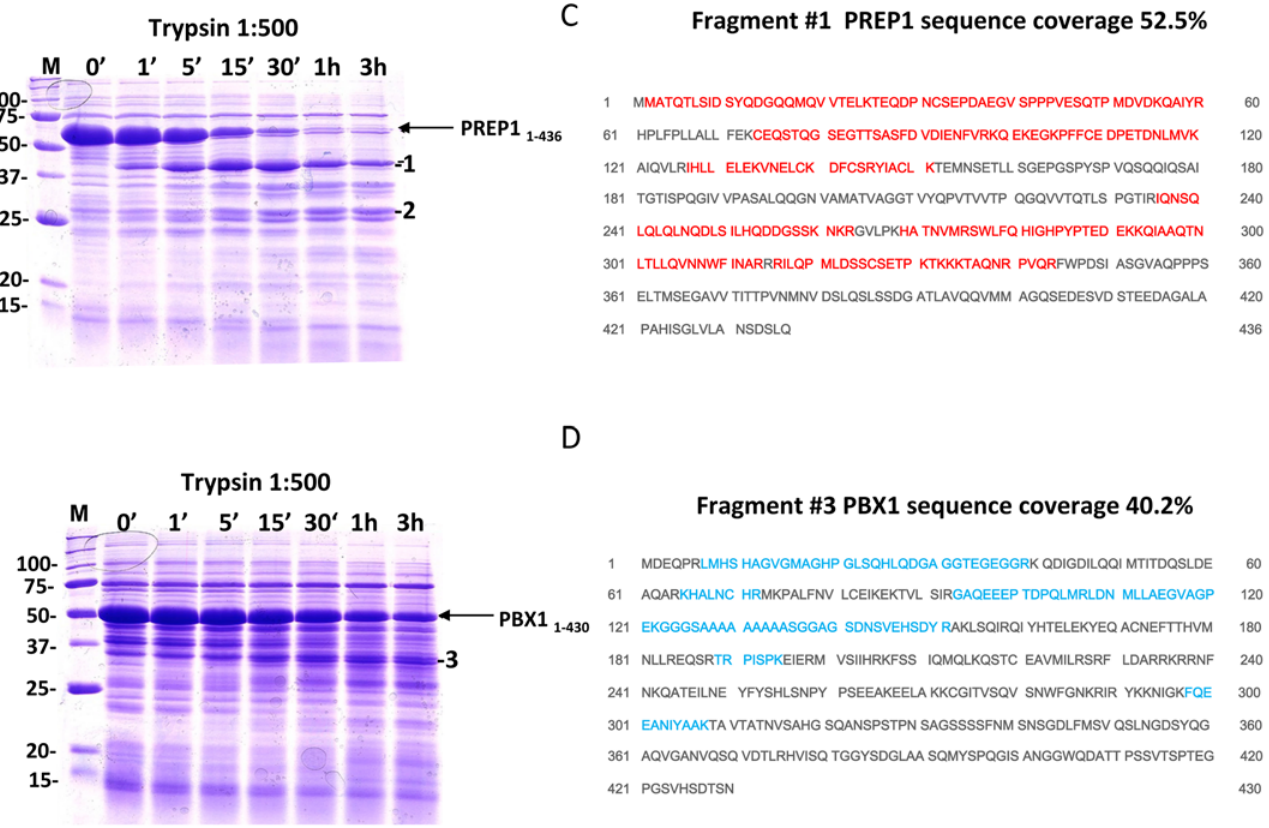
Fig 1. Limited proteolysis analysis of recombinant PREP1 and PBX1. Full length PREP1 and PBX1 were subjected to limited proteolysis with trypsin. The reactions (total volume 100 μ l) were performed at room temperature, 10 μ l volumes were taken out at the indicated time points, supplemented with sample buffer and boiled prior to loading onto SDS PAGE. The gels were Coomassie stained. A. Limited proteolysis of PREP1. Lane M, Bio-Rad size standard; two bands of ~40 kDa (1) and ~28 kDa (2) were chosen for subsequent N-terminal sequencing. B. Limited proteolysis of PBX1 with trypsin. Lane M, Bio-Rad size standard; band 3 is the proteolysis fragment chosen for mass spectrometry analysis. C and D. Identification of PREP1 and PBX1 fragments by MALDI-TOF mass spectrometry analysis. Peptides of PREP1 and PBX1 were identified by MALDI-TOF analysis after digestion of fragments 1 – 3 with trypsin. Fragment 1 contained PREP1 and the matching peptides (red) covered 52.5% starting from the N-terminus and ending at residue 344. Fragment 2 contains the N-terminal part of PREP1 excluding the homeodomain. Fragment 3 contains PBX1, and the peptides (blue) covered 40.2% of the sequence, from residue 7 to